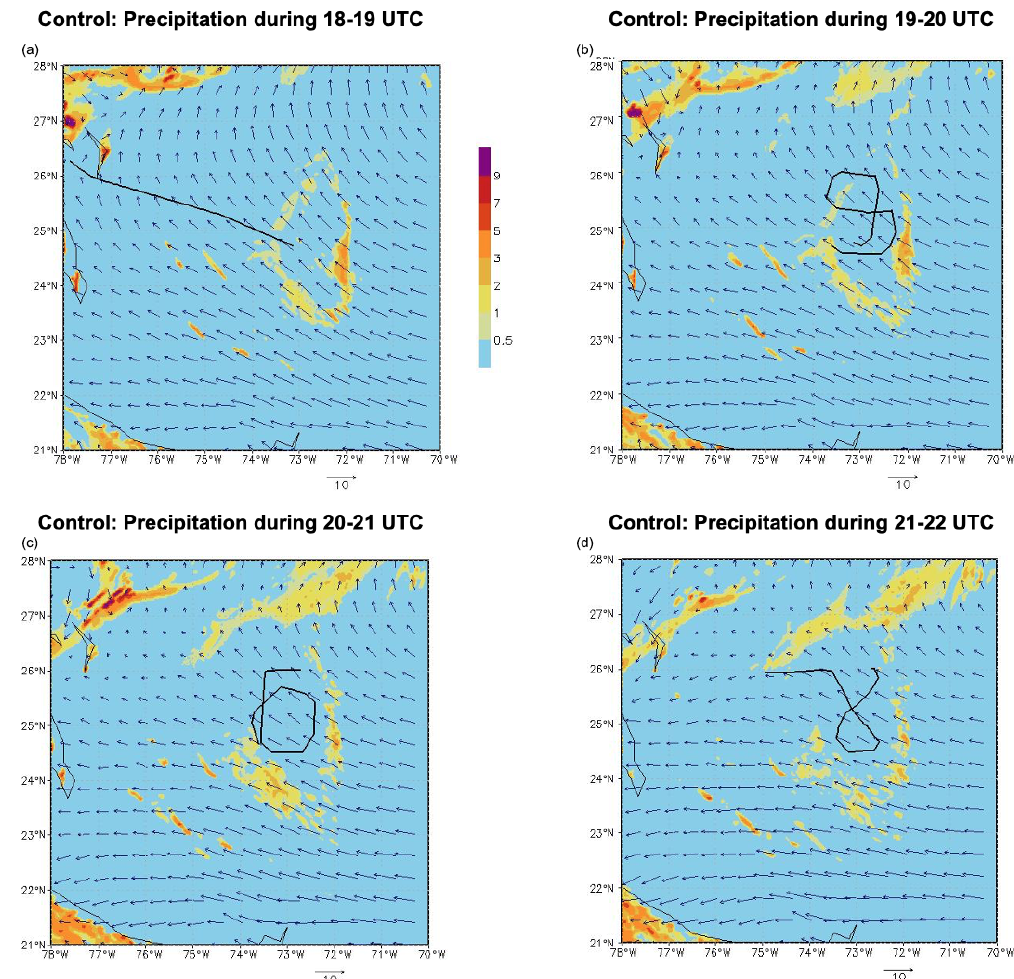
Figure 3. Left to right from upper left: precipitation from the control run for the model forecast that was output at 19:00, 20:00, 21:00, and 22:00UTC. Each period represents a 1h precipitation average (mmh − 1 ; contoured according to the scale in panel a ), and wind at the 500m level (vector) is shown. The domain is 21–28 ◦ N, 78–70 ◦ W. The lines show the DC-8 flight tracks during each 1h